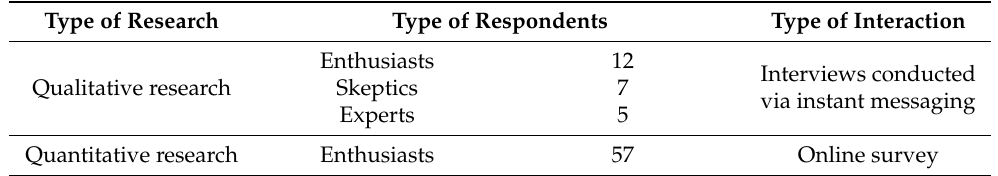
Table 1. Research